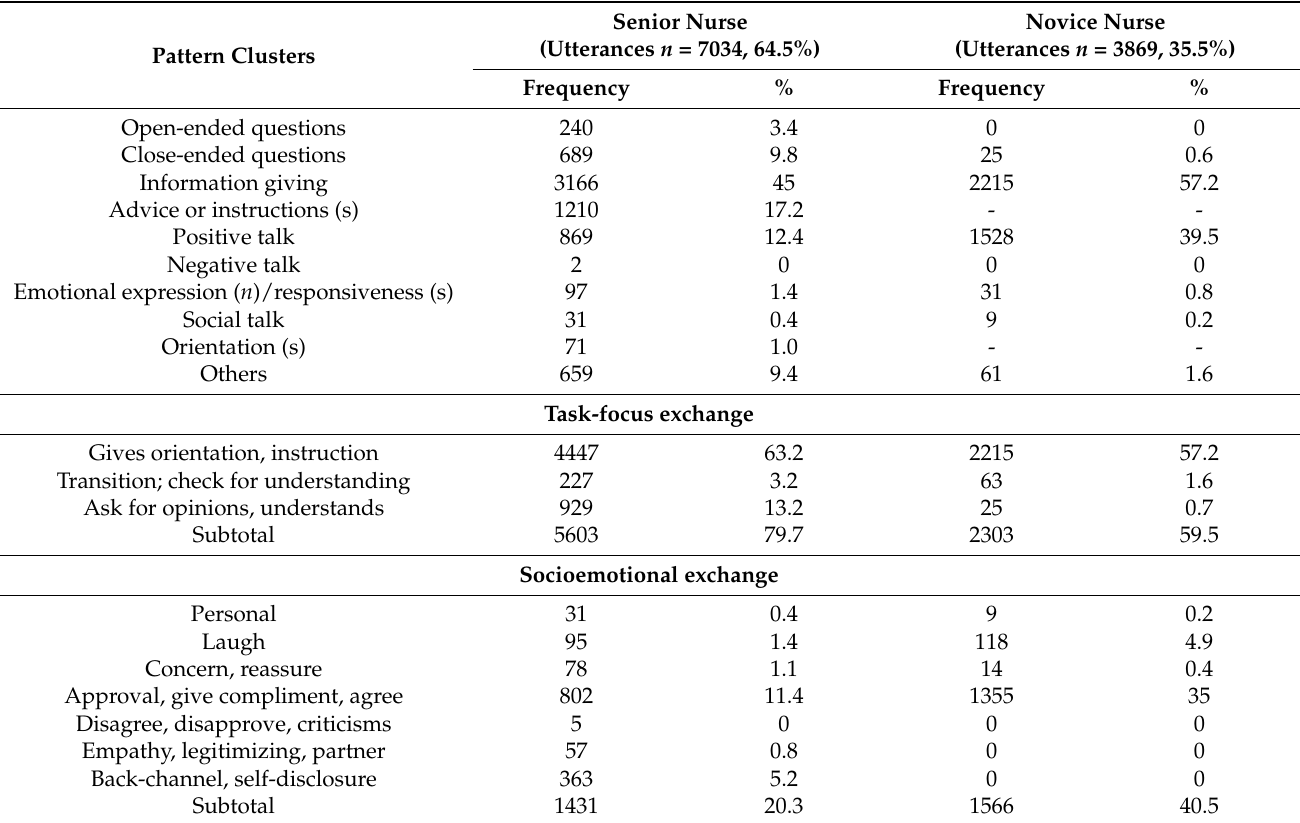
Table 4. Comparison of senior and novice nurse communication patterns: RIAS